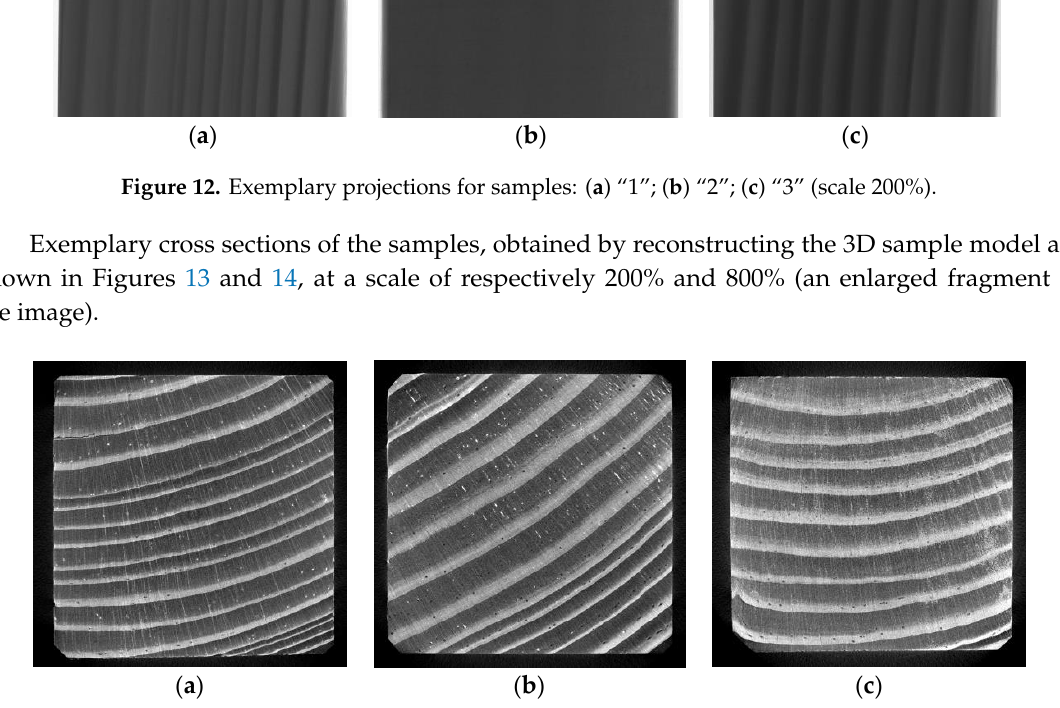
Figure 14. Exemplary cross section (scale 800%): ( a ) sample “1” ; ( b ) sample “3” ; ( c ) sample “2”. Figure 15 shows the rendering of the 3D model of the samples. ( a )